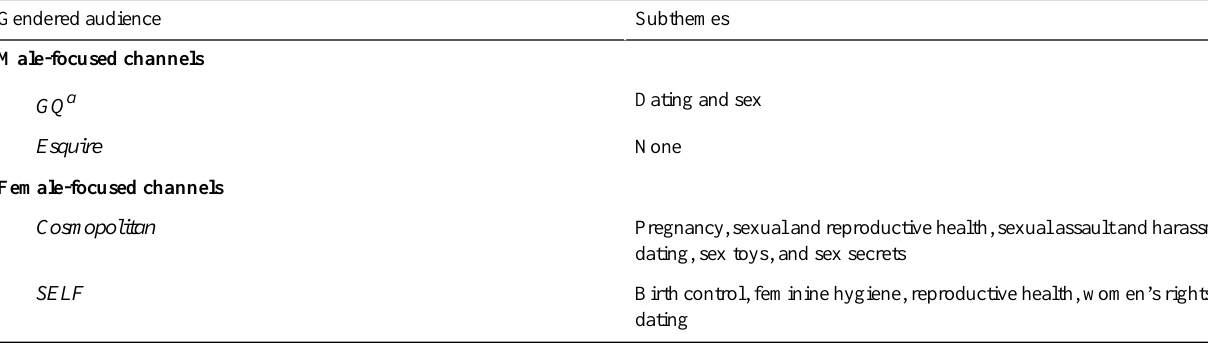
Table 4. Sexual health content subthemes of male- and female-focused sexual health